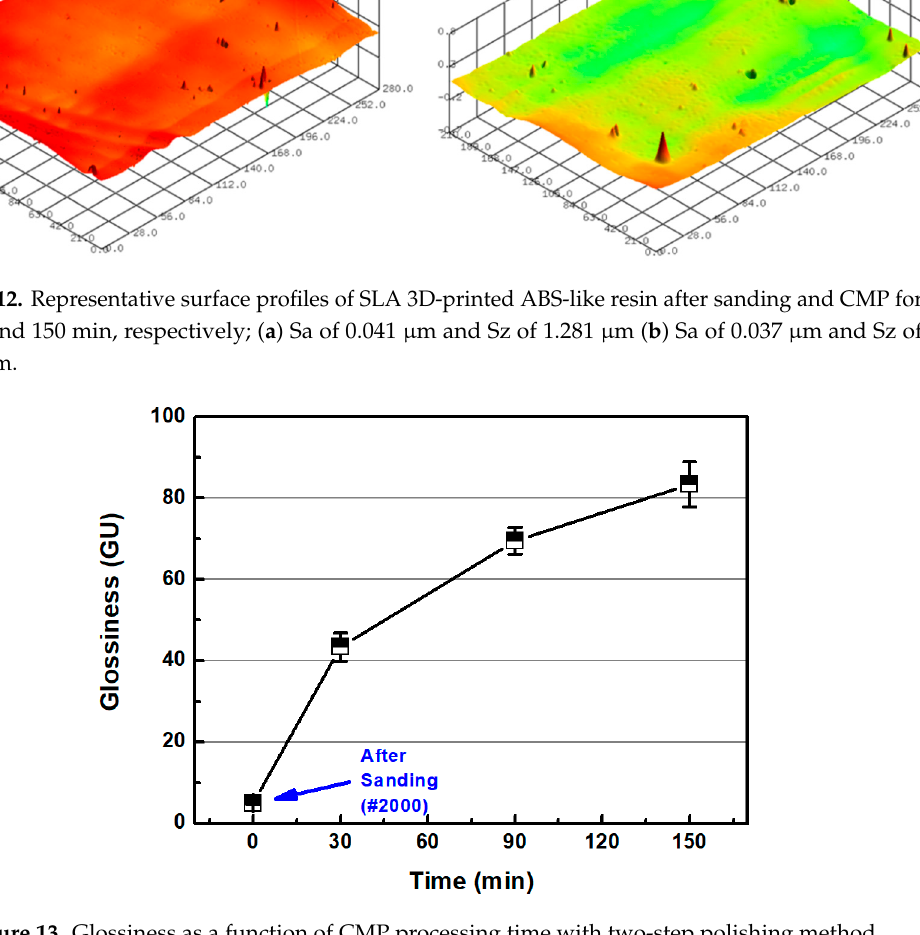
Figure 13. Glossiness as a function of CMP processing time with two-step polishing method.